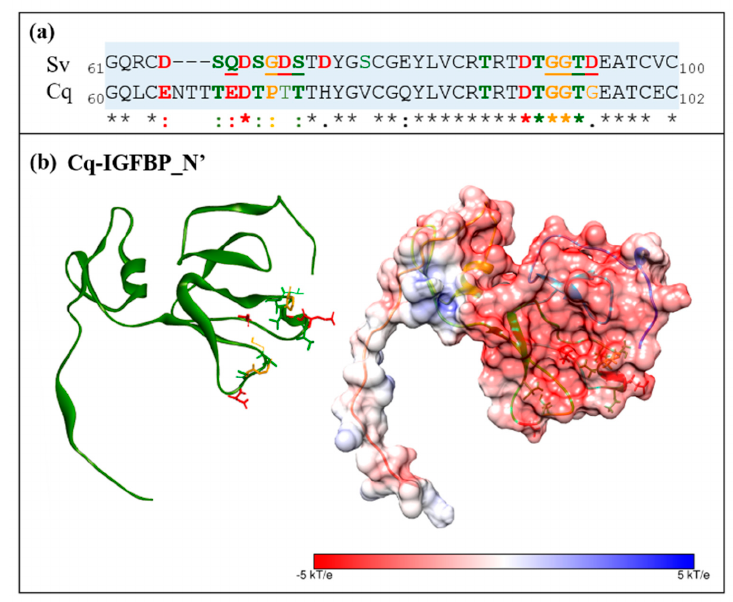
Figure 8. Comparison of Sv-IGFBP_N’ and Cq-IGFBP_N’: ( a ) sequence alignment of the focal region of Sv and Cq insulin-binding domains (boxed in blue); ( b ) Electrostatic potential surface of Cq-IGFBP_N’. All physicochemical conserved residues (predicted as interaction contacts in Sv) are highlighted in bold in sequence and as sticks in structure, the two non-conserved residues (Thr 75 and Gly 97 ) are shown in line. Throughout, red indicates negatively charged residues; green, neutrally charged; and orange, proline and glycine. Surfaces are colored by potential on the solvent accessible surface on a scale of − kT/e (red) to +kT/e (blue), as indicated by the scale bar.